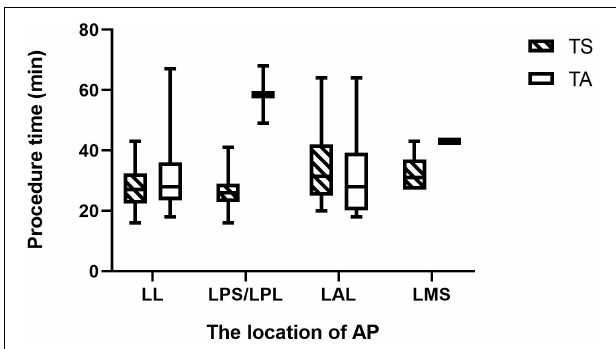
FIGURE 3 | This Box-plot presents the procedure time for APs at different locations. Although the overall procedure time did not differ between the two groups, the TS group had a shorter procedure time for patients with APs located in LPS/LPL ( P = 0.022). TS, transseptal approach; TA, aortic approach; LL, left lateral; LPS/LPL, left posterior septum/left posterior lateral; LAL, left anterior lateral; LMS, left middle septum; AP, accessory